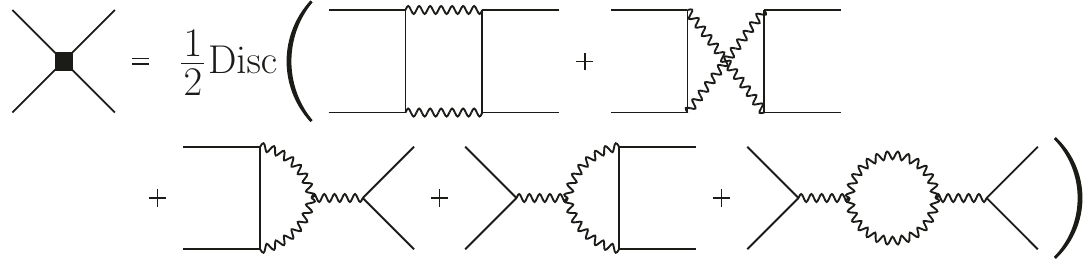
Figure 3 . E(cid:11)ective vertex of order (cid:11) 2 annihilation into two electroweak gauge